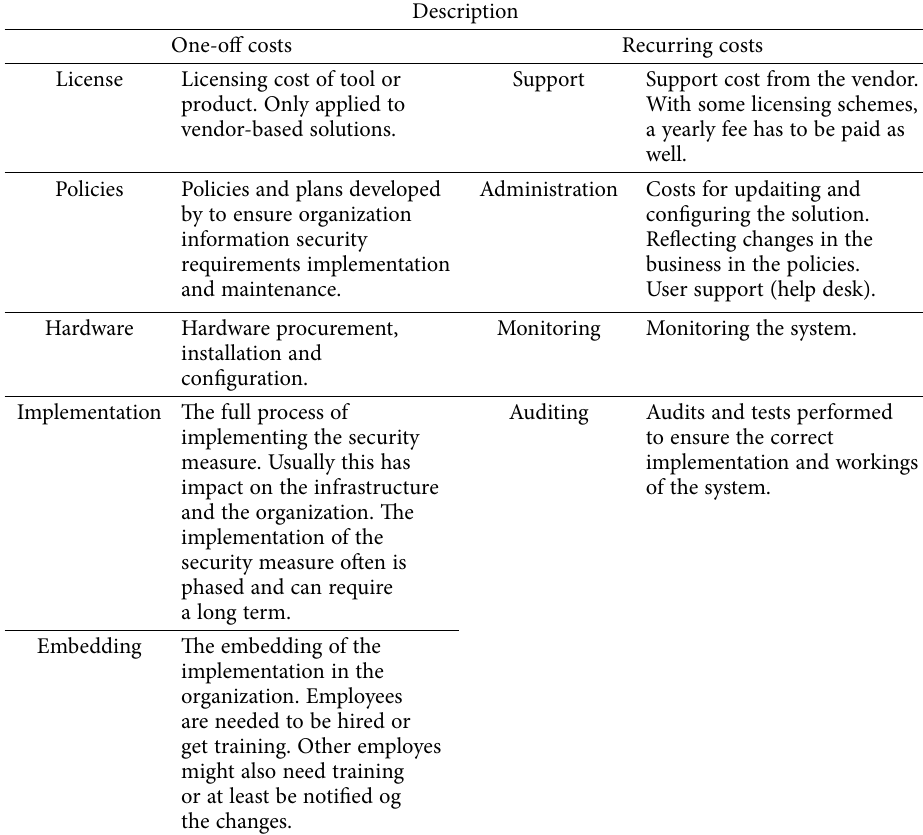
Table 1. Information security implementation